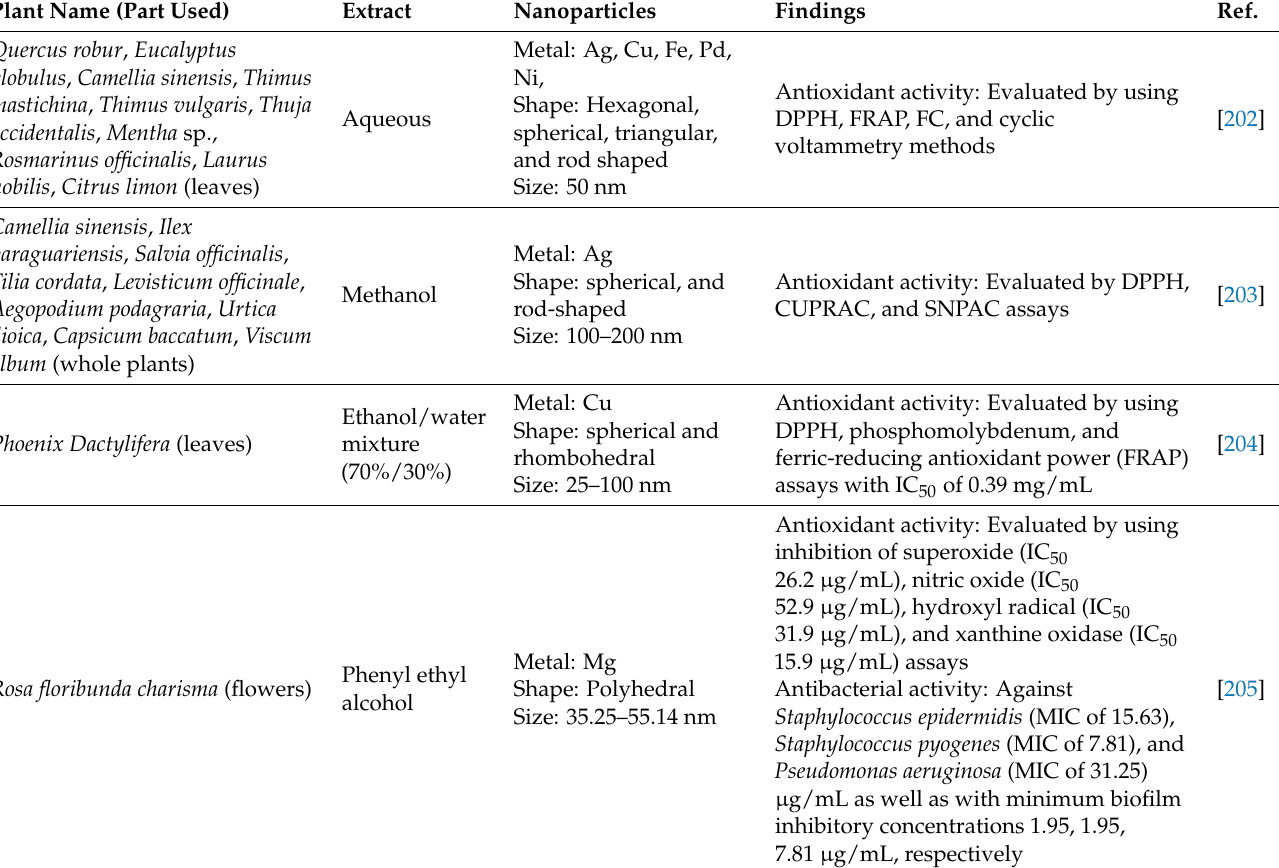
Table 2. A list of PDMNPs along with their characteristics, antioxidant, antimicrobial, and anticancer properties for the last five years